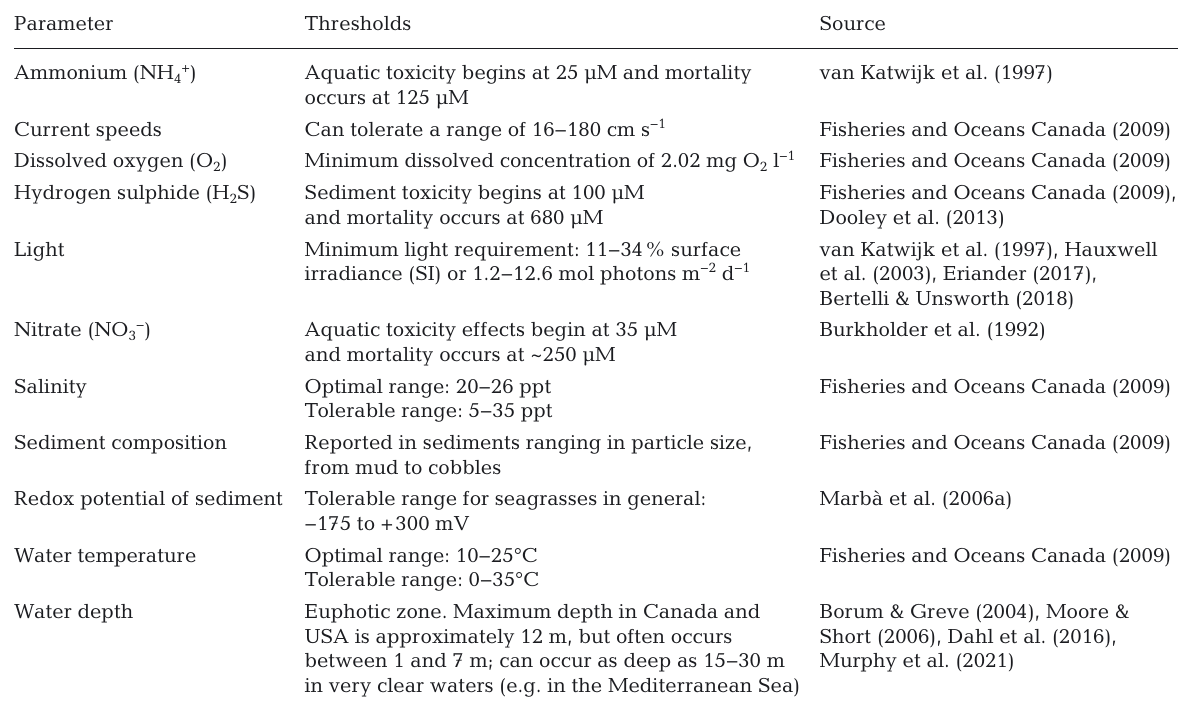
Table 1. Overview of the key environmental parameters that can affect eelgrass